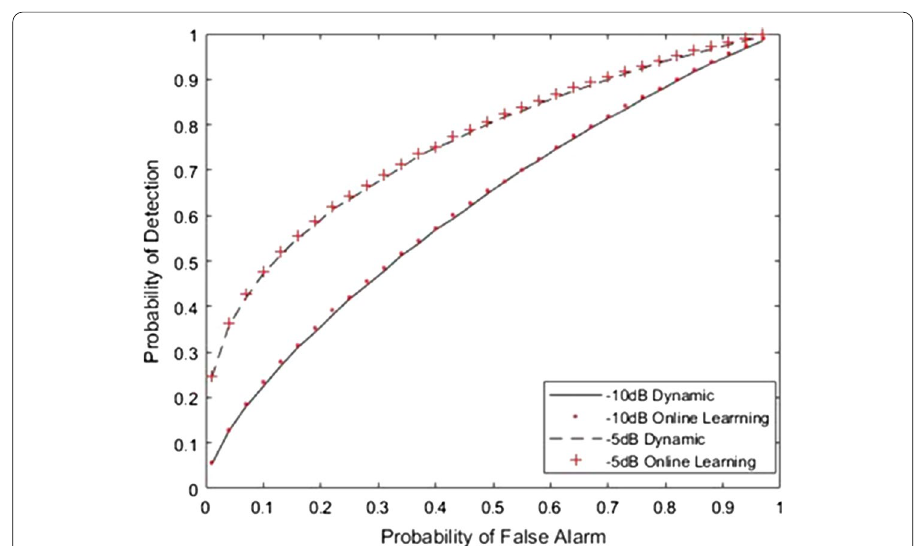
Fig. 5 ROC ( P d vs P fa ) of Energy detector sensing under Rayleigh fading channel